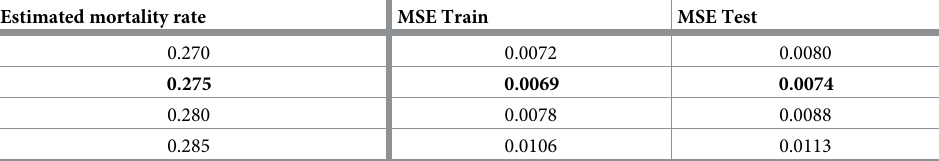
Table 12. The MSE value of ANN-PSO network after interval limiting [1,1.2] and obtaining the lowest error rate in estimating mortality rate. Estimated mortality